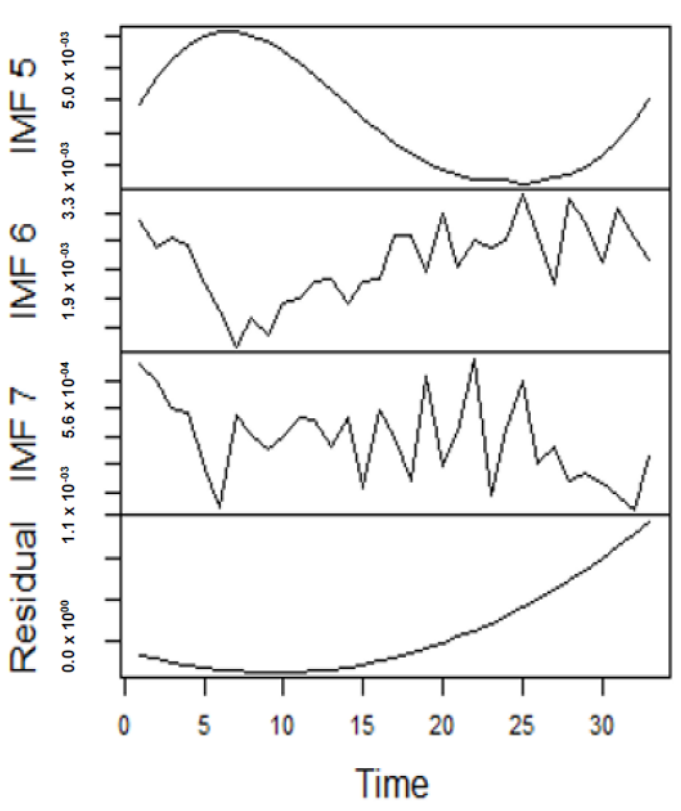
Figure 8. Part B: The remainder of the IMFs and residuals for Japan gas